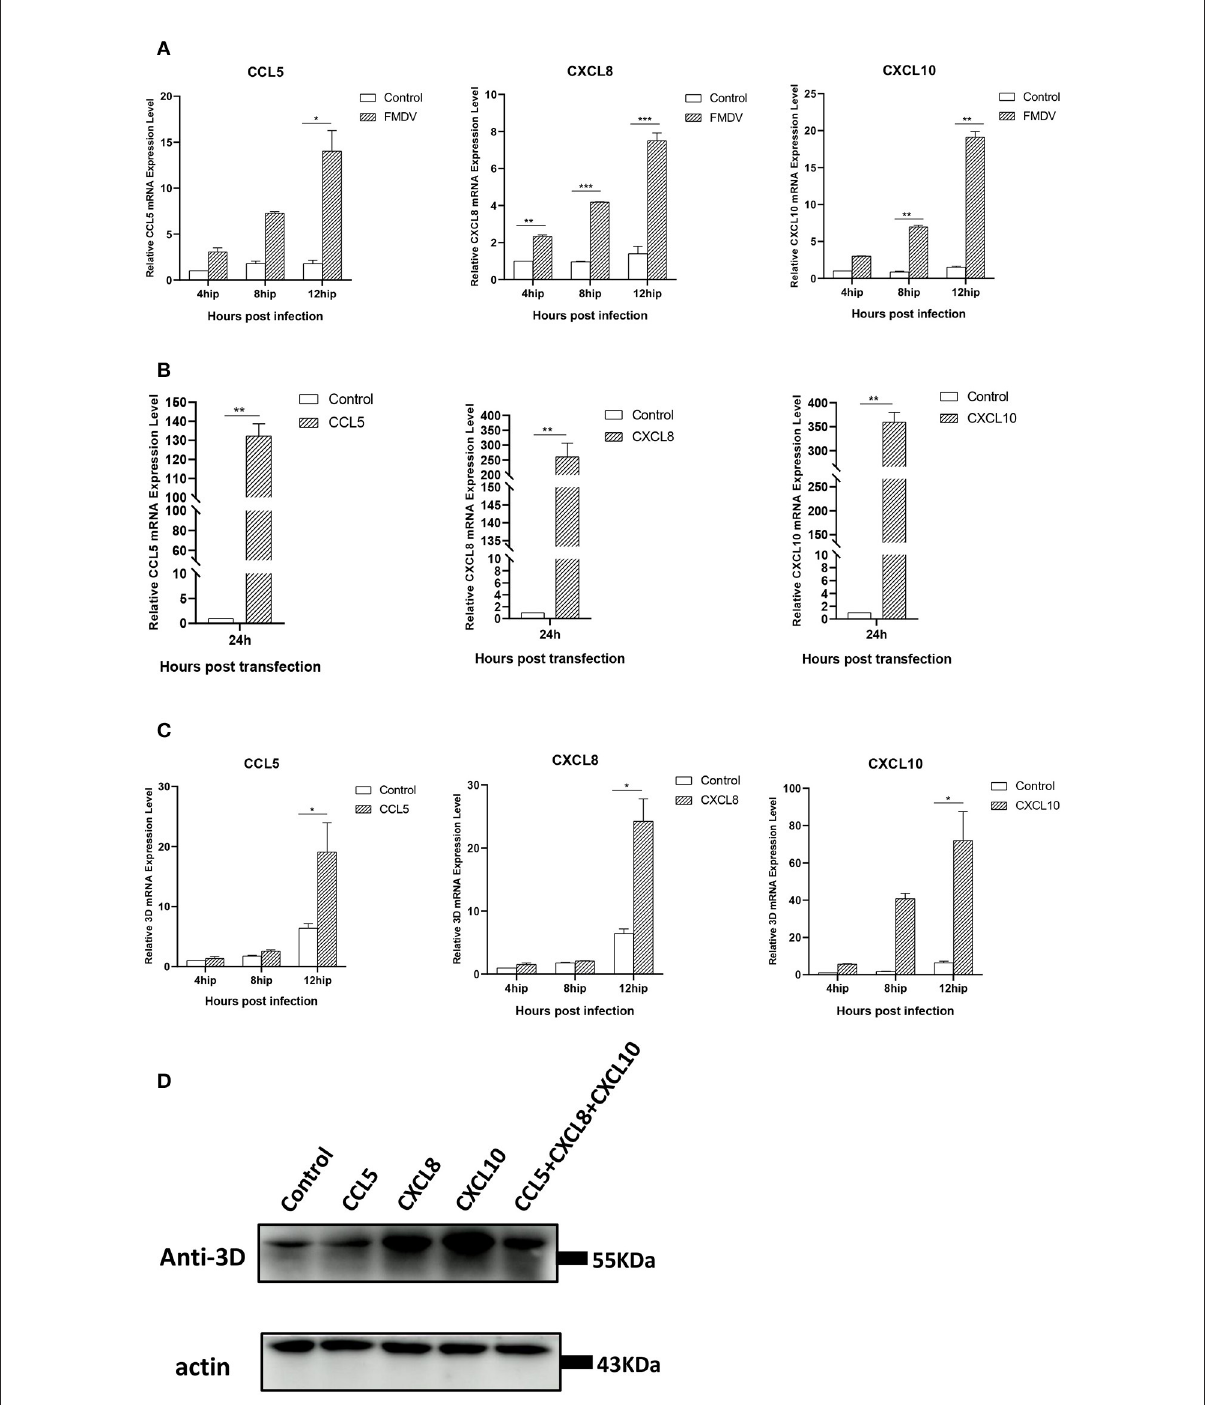
FIGURE5 The relationship between chemokines and FMDV replication. (A) FMDV induces expression of chemokines in PK-15 cells. The PK-15 cells were collected at 4, 8, and 12h after infection with FMDV at an MOI = 0.1 and then subjected to qRT-PCR assays. The mRNA levels of CCL5, CXCL8, and CXCL10 were tested. (B) The overexpression of chemokines in PK-15 cells. The pCAGGS-HA-CCL5/CXCL8/CXCL10 plasmids were transfected in PK-15 cells, respectively, and the expression levels of these chemokines were detected by qRT-PCR at 24h after transfection. (C) Chemokines promotes FMDV replication. The pCAGGS-HA-CCL5/CXCL8/CXCL10 plasmids were transfected in PK-15 cells, respectively. At 24h post-transfection, the cells were collected at 4, 8, and 12h after infection with FMDV at an MOI = 0.1 and then subjected to qRT-PCR assays. The relative 3D gene mRNA levels were tested. The significant difference is marked by “ * ” ( P < 0.05), “ ** ” ( P < 0.01), and “ *** ” ( P < 0.001). (D) PK-15 cells were transfected with pCAGGS-HA- CCL5/CXCL8/CXCL10 plasmid or co-transfected with these three plasmids for 24h, followed by infection with FMDV for 12h. The viral 3D protein was detected by Western